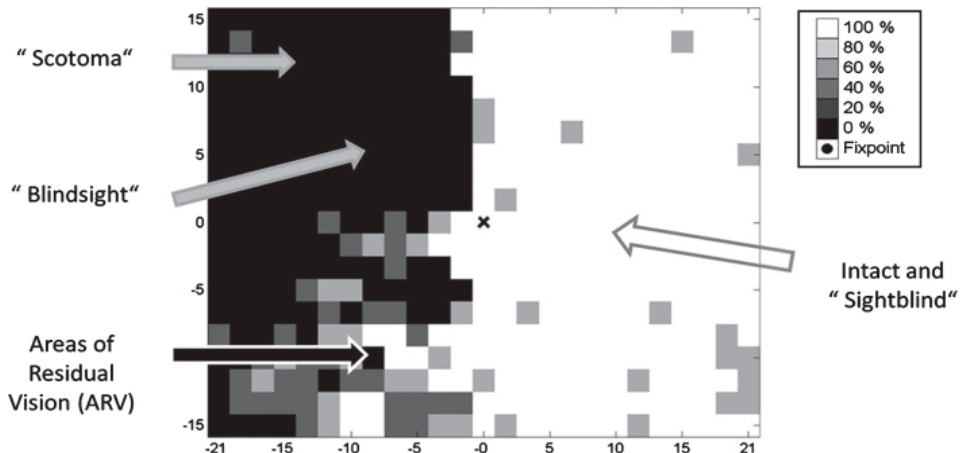
Figure 4. Subtle deficits and residual functions in visual fields with CVI. The phenomenon of blindsight occurs when otherwise blind individuals can correctly guess that stimuli were presented without the individual’s awareness of them. CVI individuals can correctly respond to visual stimuli, but they report seeing nothing (unconsciously seeing without knowing). These are areas in the visual field which are neither blind nor seeing normally (areas that are blind (black), partially impaired (grey), or normal (white)). Visual fields typically have different “shades of grey” where function is neither completely lost nor normal. Here blind individuals only occasionally respond to stimulation. With repeated testing, these visual field regions are variably responsive and are associated with increased thresholds and longer response time. X and Y axes represent the degree of angular subtense from central fixation. The concealed deficits in the “seeing field” effectively render individuals “sightblind”, measured by examinations that can measure higher cognitive dysfunctions. Especially clinically relevant is the grey “area of residual vision”, where vision is neither normal nor absent. These are the regions of the visual field with the greatest recovery potential. (from Sabel et al. [146], with